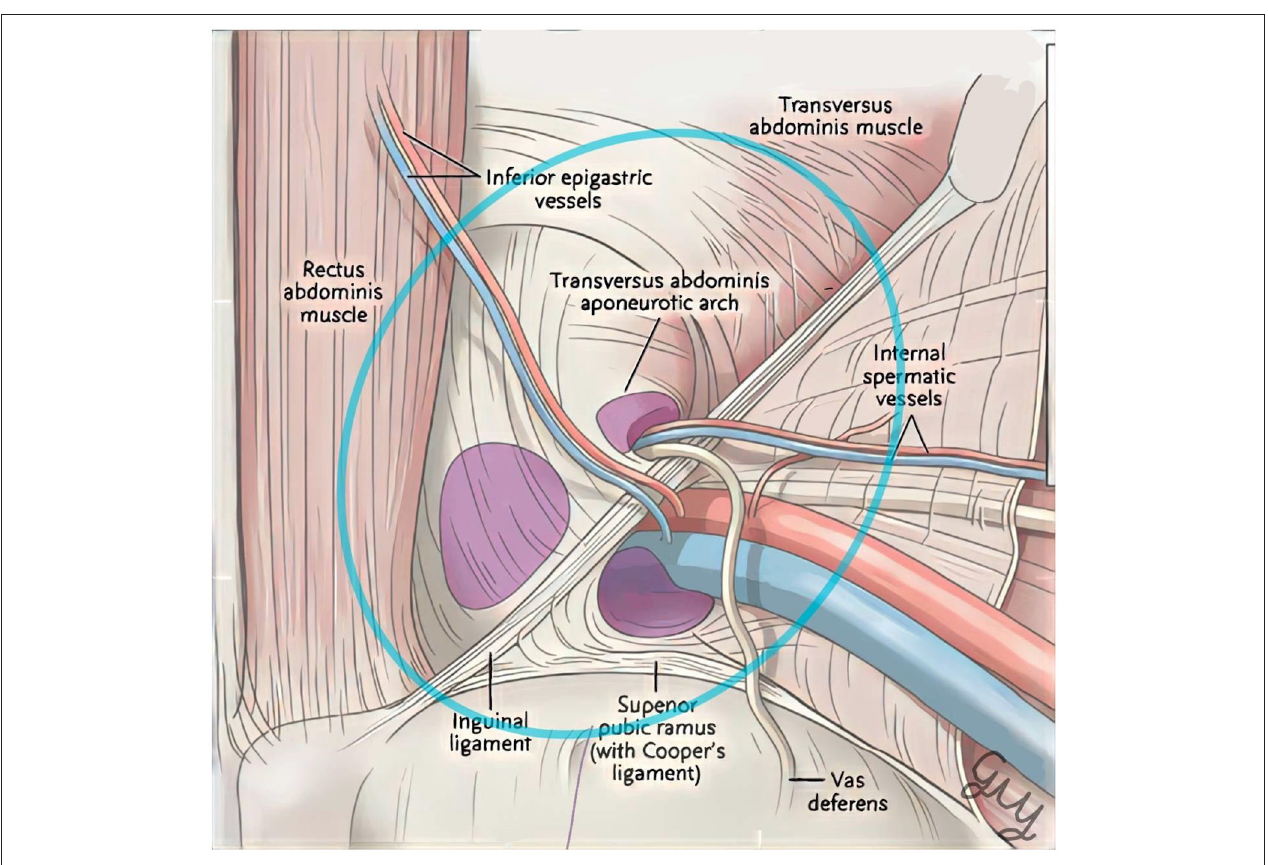
FIGURE 2 | The myopectineal orifice area calculation.